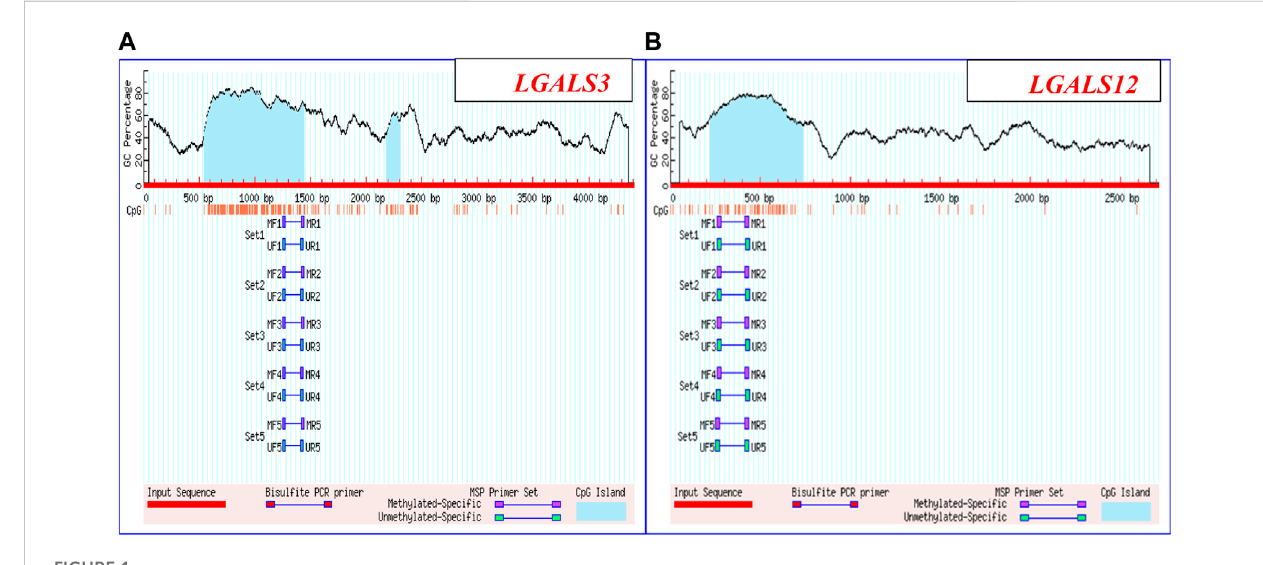
FIGURE 1 LGALS3 & 12 promoter regions: (A) Promoter region of LGALS3 : Chromosome 14: 55128400-55132801 & (B) Promoter region of LGALS12 : Chromosome 11: